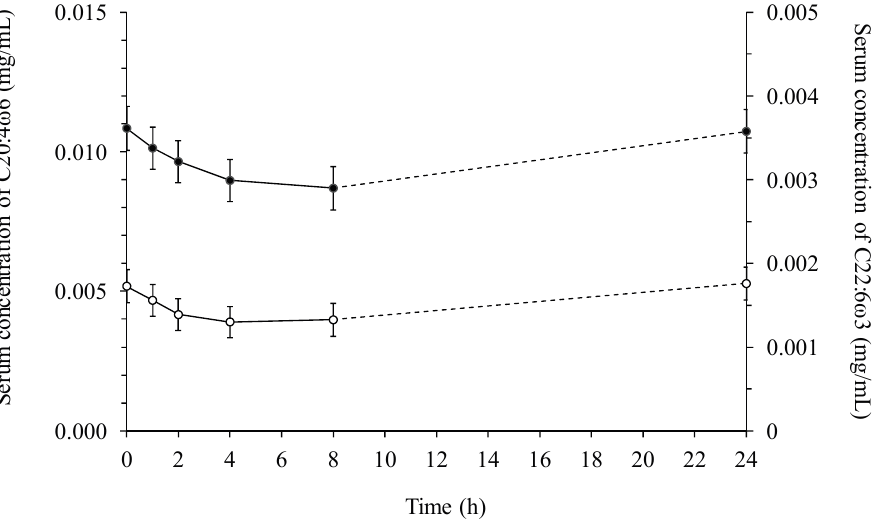
Figure 6. The concentration (mg/mL) of arachidonic (C20:4 ω 6, ● left) and docosahexaenoic (C22:6 ω 3, ○ right) acid in serum across diets over